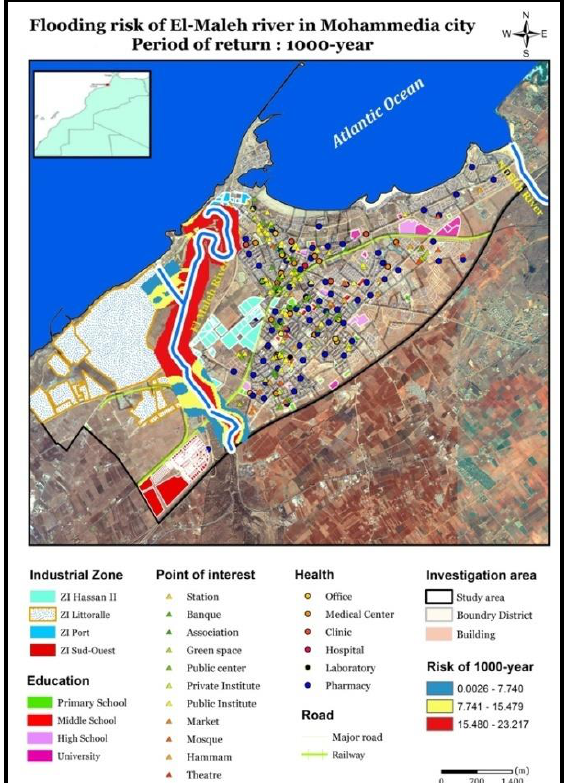
Figure 12. Flooding risk of a Millennial